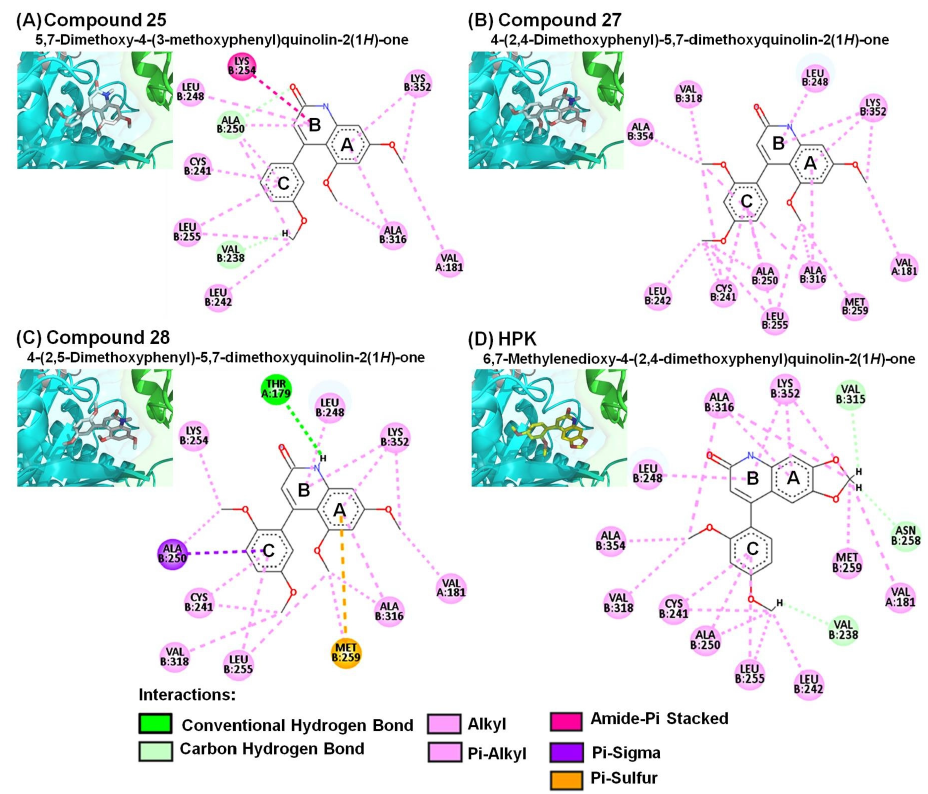
Figure 6. Close-up of ( A ) 25 , ( B ) 27 , ( C ) 28, and ( D ) HPK within the colchicine-binding site of the αβ -tubulin shown along with their corresponding 2D interaction plots.